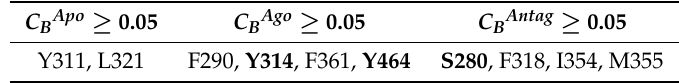
Table 1. List of key residues with betweenness centrality values ( C B ) ≥ 0.05.